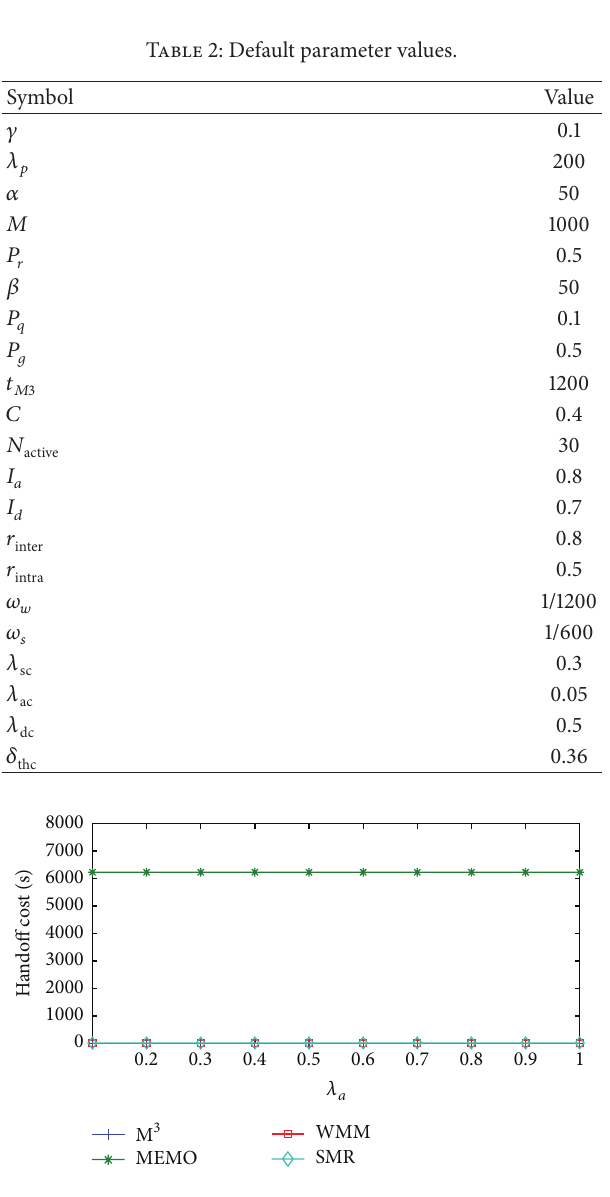
Figure 4: Handoff cost/sec versus 𝜆 𝑎